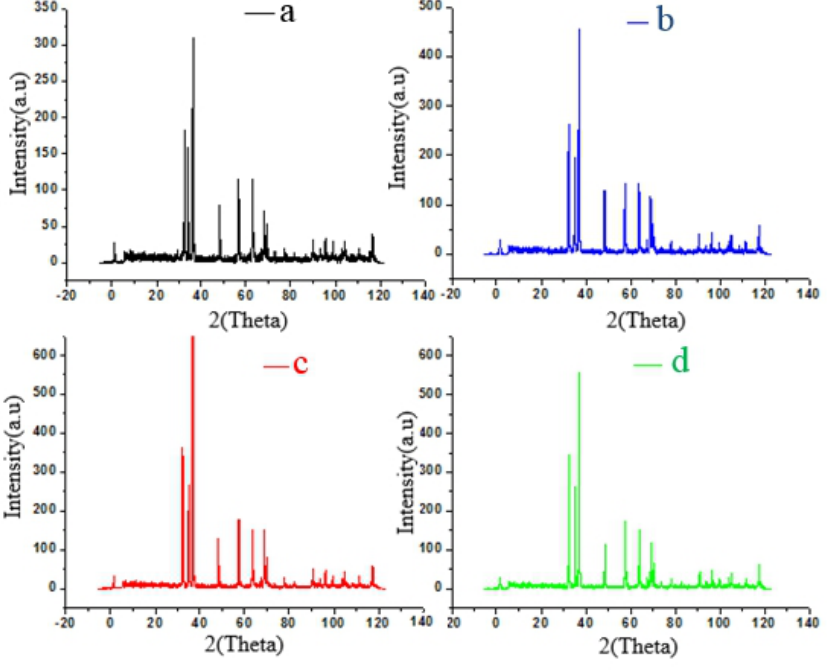
Fig. 2. XRD Diffractogram a) ZnO b) WO-ZnO 0.5% c) WO-ZnO 1% d) WO-ZnO 2%